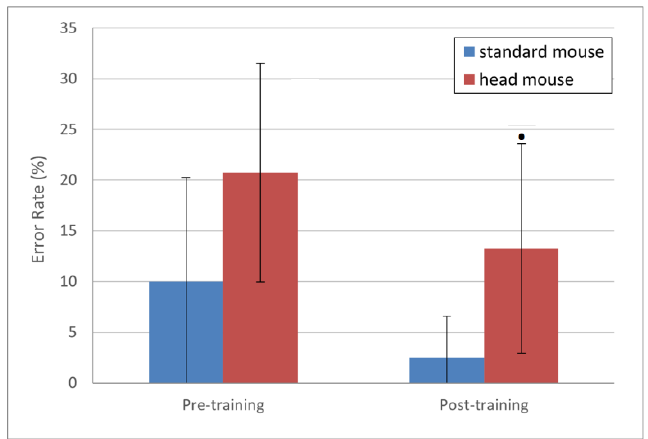
Figure 6. Error rate (%) mean values and standard deviations. Statistically significant changes for the head mouse ( p < 0.1 [ · ]) (not normally distributed samples, parametric test: Wilcoxon signed rank test with continuity correction with paired samples).